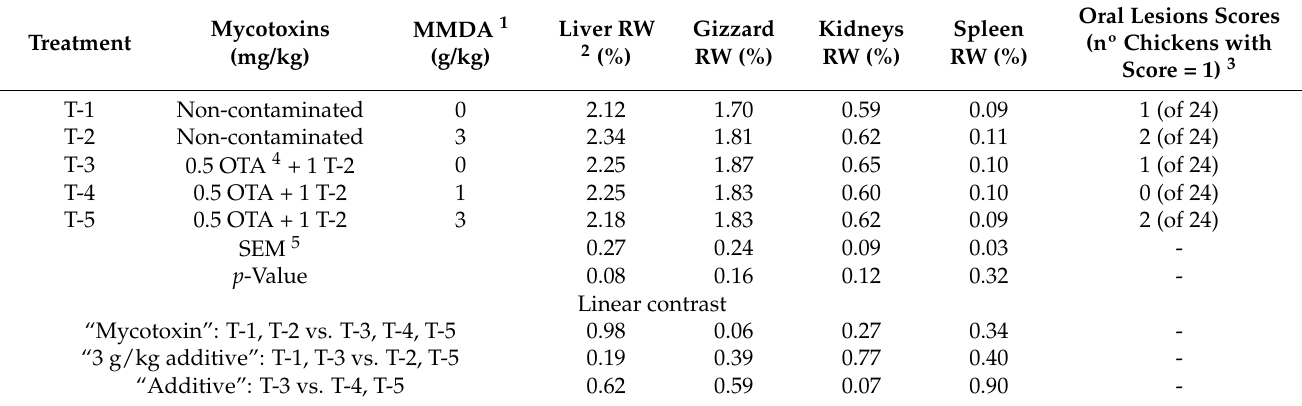
Table 8. The effects of feeding ochratoxin A (OTA) and T-2 mycotoxins and the addition of a binder mycotoxin product (MMDA) on relative weight of organs and oral lesions in broiler chickens.